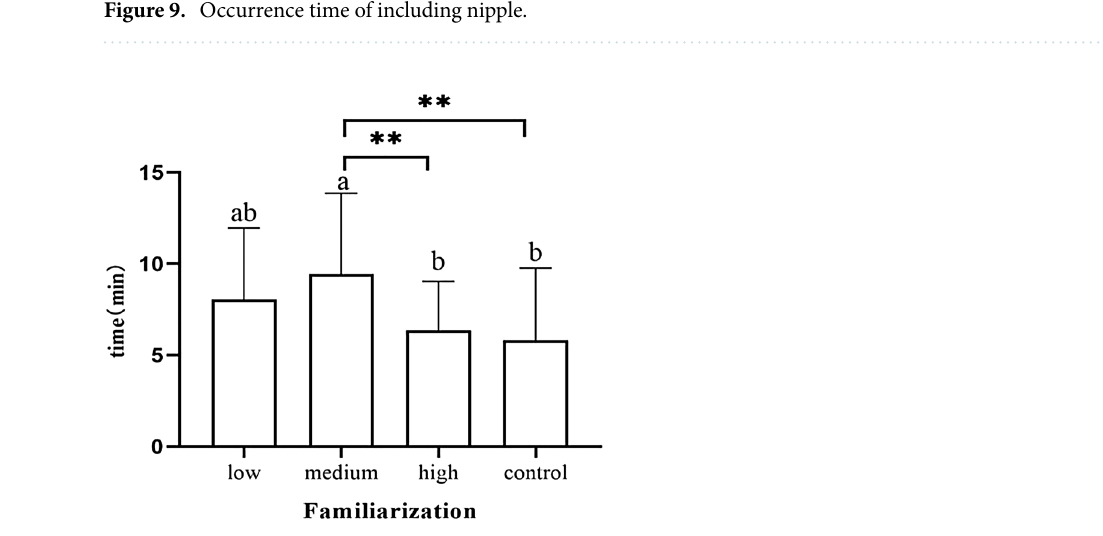
Figure 10. Duration of familiarization stage.